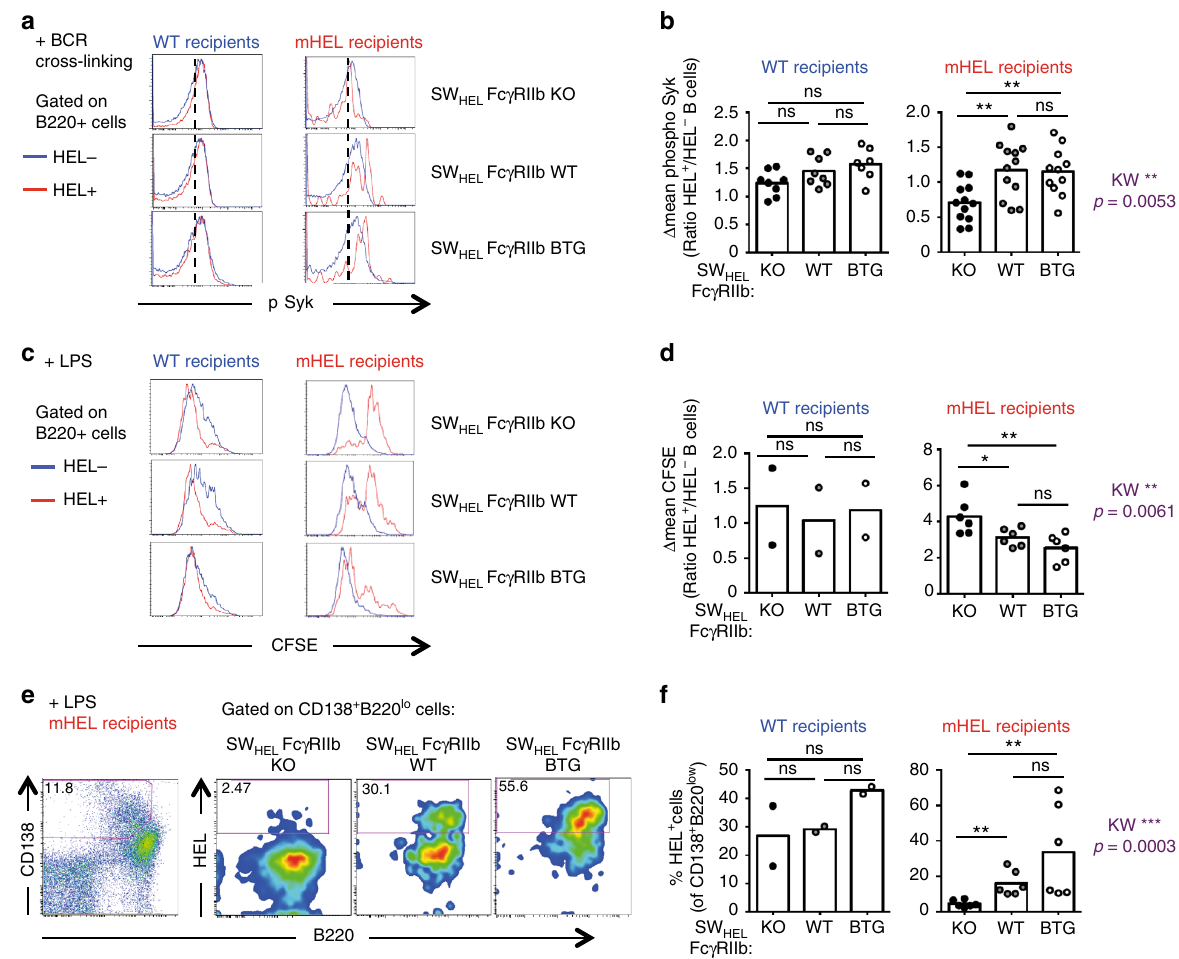
Fig. 3 Absence of Fc γ RIIb expression enhances autoreactive B-cell anergy. a Representative histograms of phospho-Syk on HEL-speci fi c (HEL + , red histograms) and HEL-non speci fi c (HEL − , blue histograms) splenic B cells from WT and mHEL recipient chimeras reconstituted with SW HEL -Fc γ RIIb KO, SW HEL -Fc γ RIIb WT and SW HEL -Fc γ RIIb BTG BM and measured by fl ow cytometry after BCR cross-linking. A dashed line indicates the staining